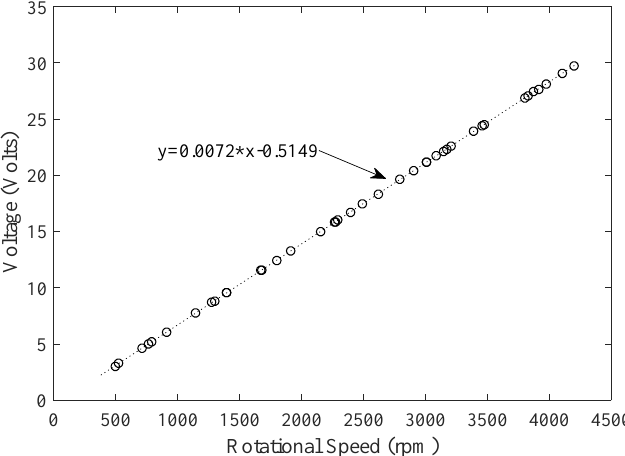
Figure 12. Test results for voltage and